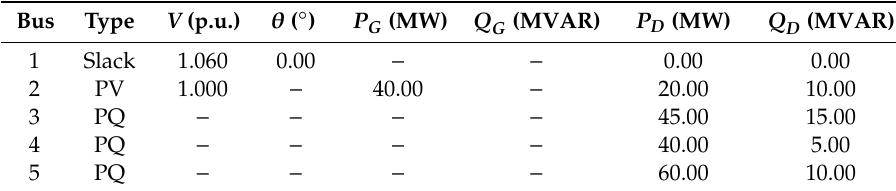
Figure 1. Single-line diagram of a three-bus MT-HVDC system. Table 1. Parameters of the AC system.